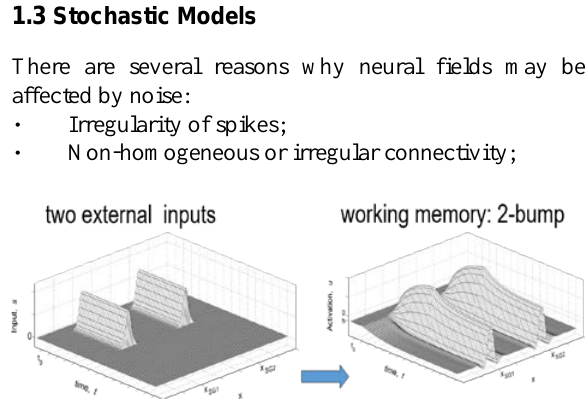
Figure 2. External stimuli and their representations in working